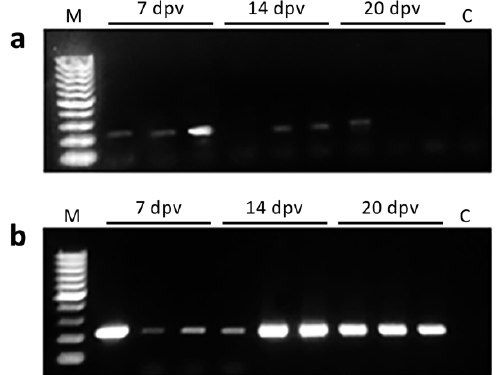
Figure 2. Detection of mcp transcripts in vaccinated gilthead seabream at 7, 14, and 20 days post- vaccination (dpv) in ( a ) muscle at the site of injection, and ( b ) head kidney; M, molecular weight marker (100 bp DNA ladder); C, negative control (fish injected with the empty plasmid). No mortality or signs of disease were registered during the experimental period (10 dpi). In fish injected with the empty plasmid (pcDNA), viral genome was detected in 83.3% of samples analyzed at 2 dpi and in all samples analyzed at 10 dpi (Figure 3a). Estimated viral load was (1.6 ± 0.9) × 10 1 copies of viral DNA/mg of tissue at 2 dpi. A statistically significant ( p < 0.05) increase was observed at 10 dpi, with a mean viral load of (1.4 ± 0.7) × 10 2 copies of viral DNA/mg of tissue (Figure 3c). Only 33.3% of the pcDNA-MCP vaccinated fish analyzed tested positive for LCDV-Sa genome, both at 2 and 10 dpi (Figure 3b), with a mean viral load of (3.0 ± 1.2) × 10 1 copies of viral DNA/mg of tissue, no statistically significant ( p < 0.05) differences being observed in viral loads at different days post-infection (Figure 3c). Viral DNA was not detected in any of the caudal fin samples from control fish (injected with L15 medium).